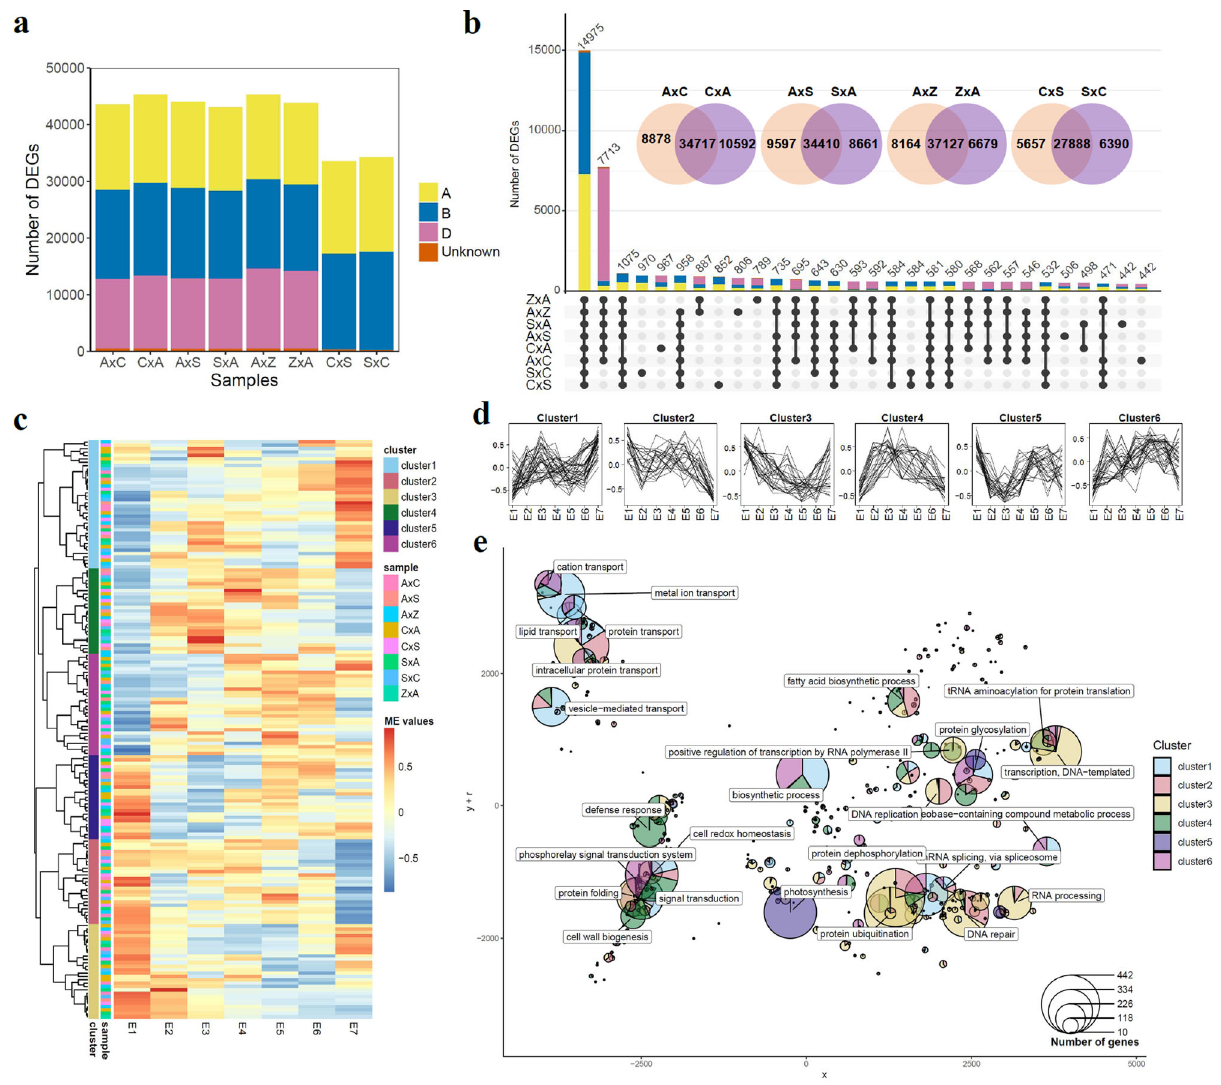
Fig. 2 Differential expression analysis and clustering of expression patterns across multiple samples. a The number of differentially expressed genes (DEGs) in each sample. DEGs were identi fi ed through comparisons between each time point against the two-cell stage for each sample. b Number of DEGs shared between crosses as shown by UpSet plots and Venn diagrams. c Clustering of module eigengene values (MEs). MEs represent the fi rst principal component of each WGCNA module(or cluster) in each of the eight reciprocal cross samples. A total of 170 clusters were identi fi ed and ME values of each cluster were hierarchically clustered. d Expression pattern of six distinct clusters identi fi ed from hierarchical clustering. e Scatterpie chart showing the signi fi cantly enriched GO terms of each cluster. GO terms were slimmed by grouping similar terms based on their semantic similarity. Each circle in the pieplot represents a GO term in biological processes. Distances between each circle were determined by their GO similarity and axes are the fi rst two components of applying a PCA to the similarity matrix. Size of each circle represents the total number of genes in the GO term. Proportion of genes from different clusters in each circle were colored as